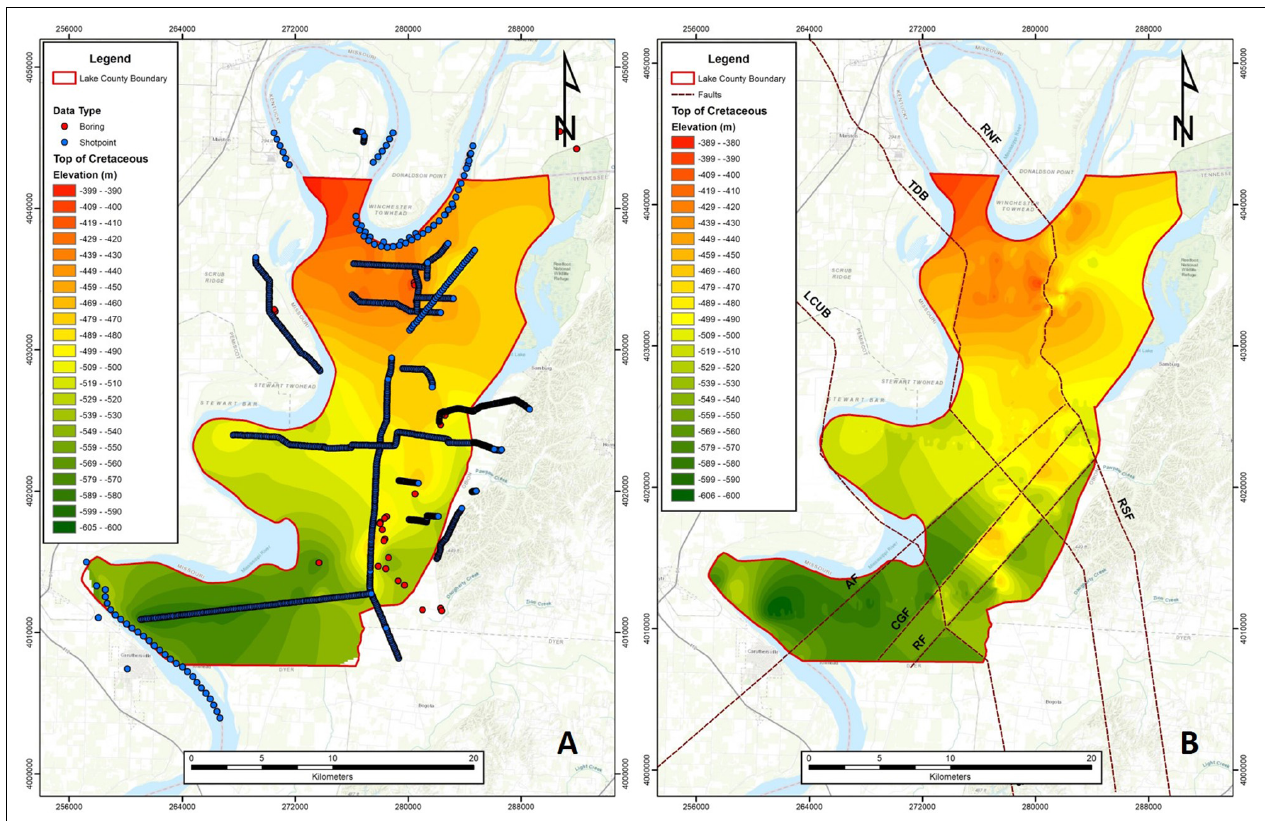
FIGURE 6 | (A) Structure contour map of the top of the Cretaceous strata. (B) Faulted structure contour map of the top of the Cretaceous strata. AF, Axial; CGF, Cottonwood Grove; RF, Ridgely; RNF, Reelfoot North; RSF, Reelfoot South; TDB, Tiptonville dome back thrust; LCUB, Lake County uplift back thrust faults. Contour interval is 10